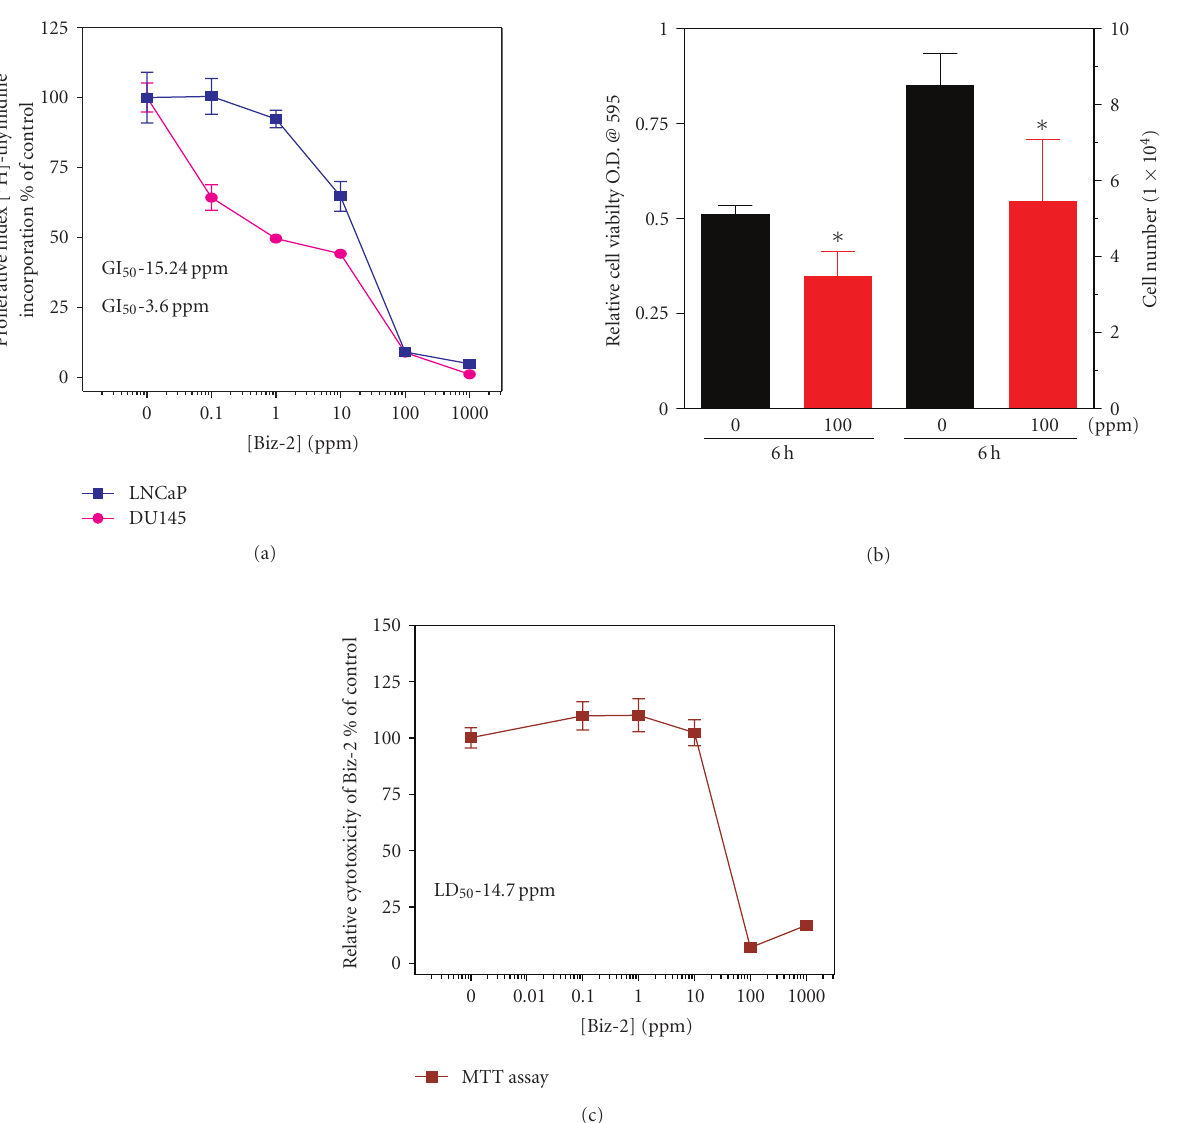
Figure 5: Modulation of prostate cell proliferation by Bizzy nut extracts. LNCaP or DU145 cells were grown in the presence of 0–1000 ppm Biz-2 for 24 hours, and cell growth was determined using (a) 3 [H] thymidine incorporation, (b) MTT cell viability assay and tryphan blue dye staining, and (c) cytotoxicity of Biz-2 in LNCaP cells that was performed as described in Section 2. Growth inhibitory activity of the extracts was determined as [(A 490(control) − A 490(extract) ) / A 490(control) ] × 100. Each value represents mean ± SEM for three experiments performed in eight wells of a 96-well plate. Values followed by ∗ P < . 05 di ff ered significantly from the